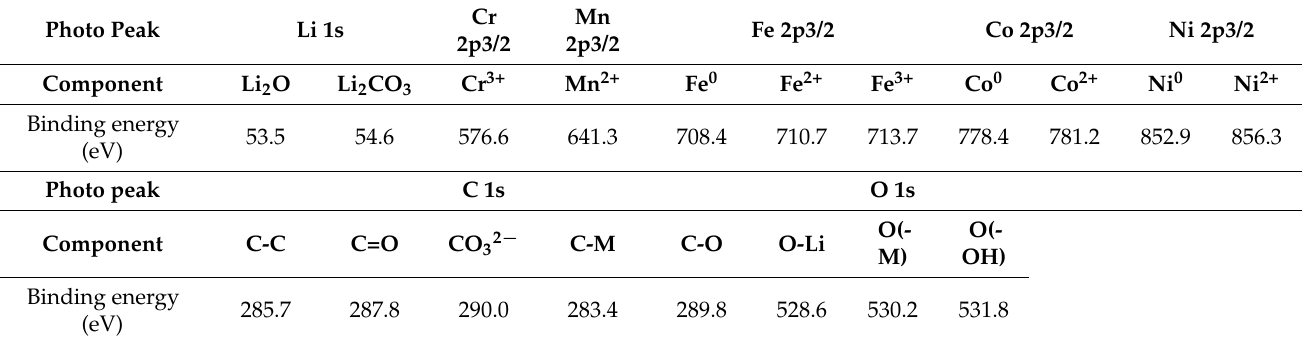
Table 3. Binding energies of Li 1 s, C 1 s, O 1 s, Cr 2p, Mn 2p, Fe 2p, Co 2p, and Ni 2p